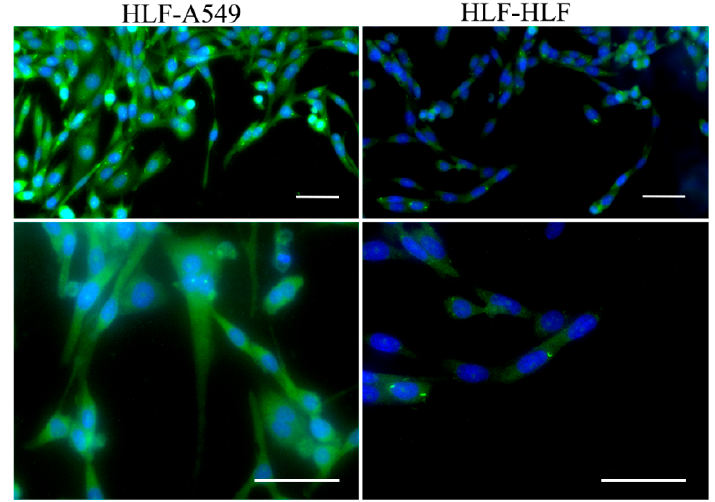
Figure 6. Histograms of average migration distances of cells for co-culture group compared with control groups. ( a ) Average migration distance of HLF at corresponding different times for HLF–A549 and HLF–HLF groups. ( b ) Average migration distance of A549 at corresponding different times for HLF–A549 and A549–A549 groups. (* p < 0.05)